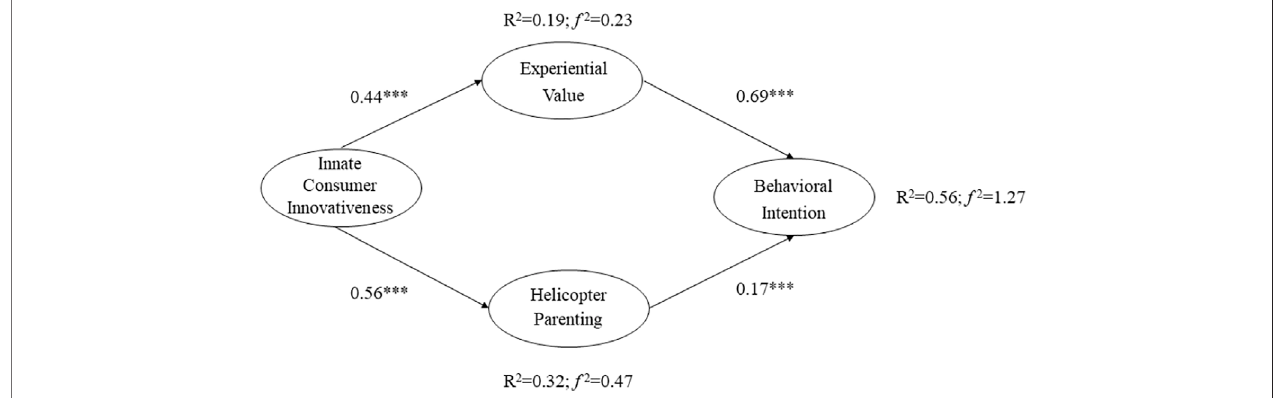
FIGURE 2 | The structural model with standardized coef fi cients (Note: *** p < 0.001).